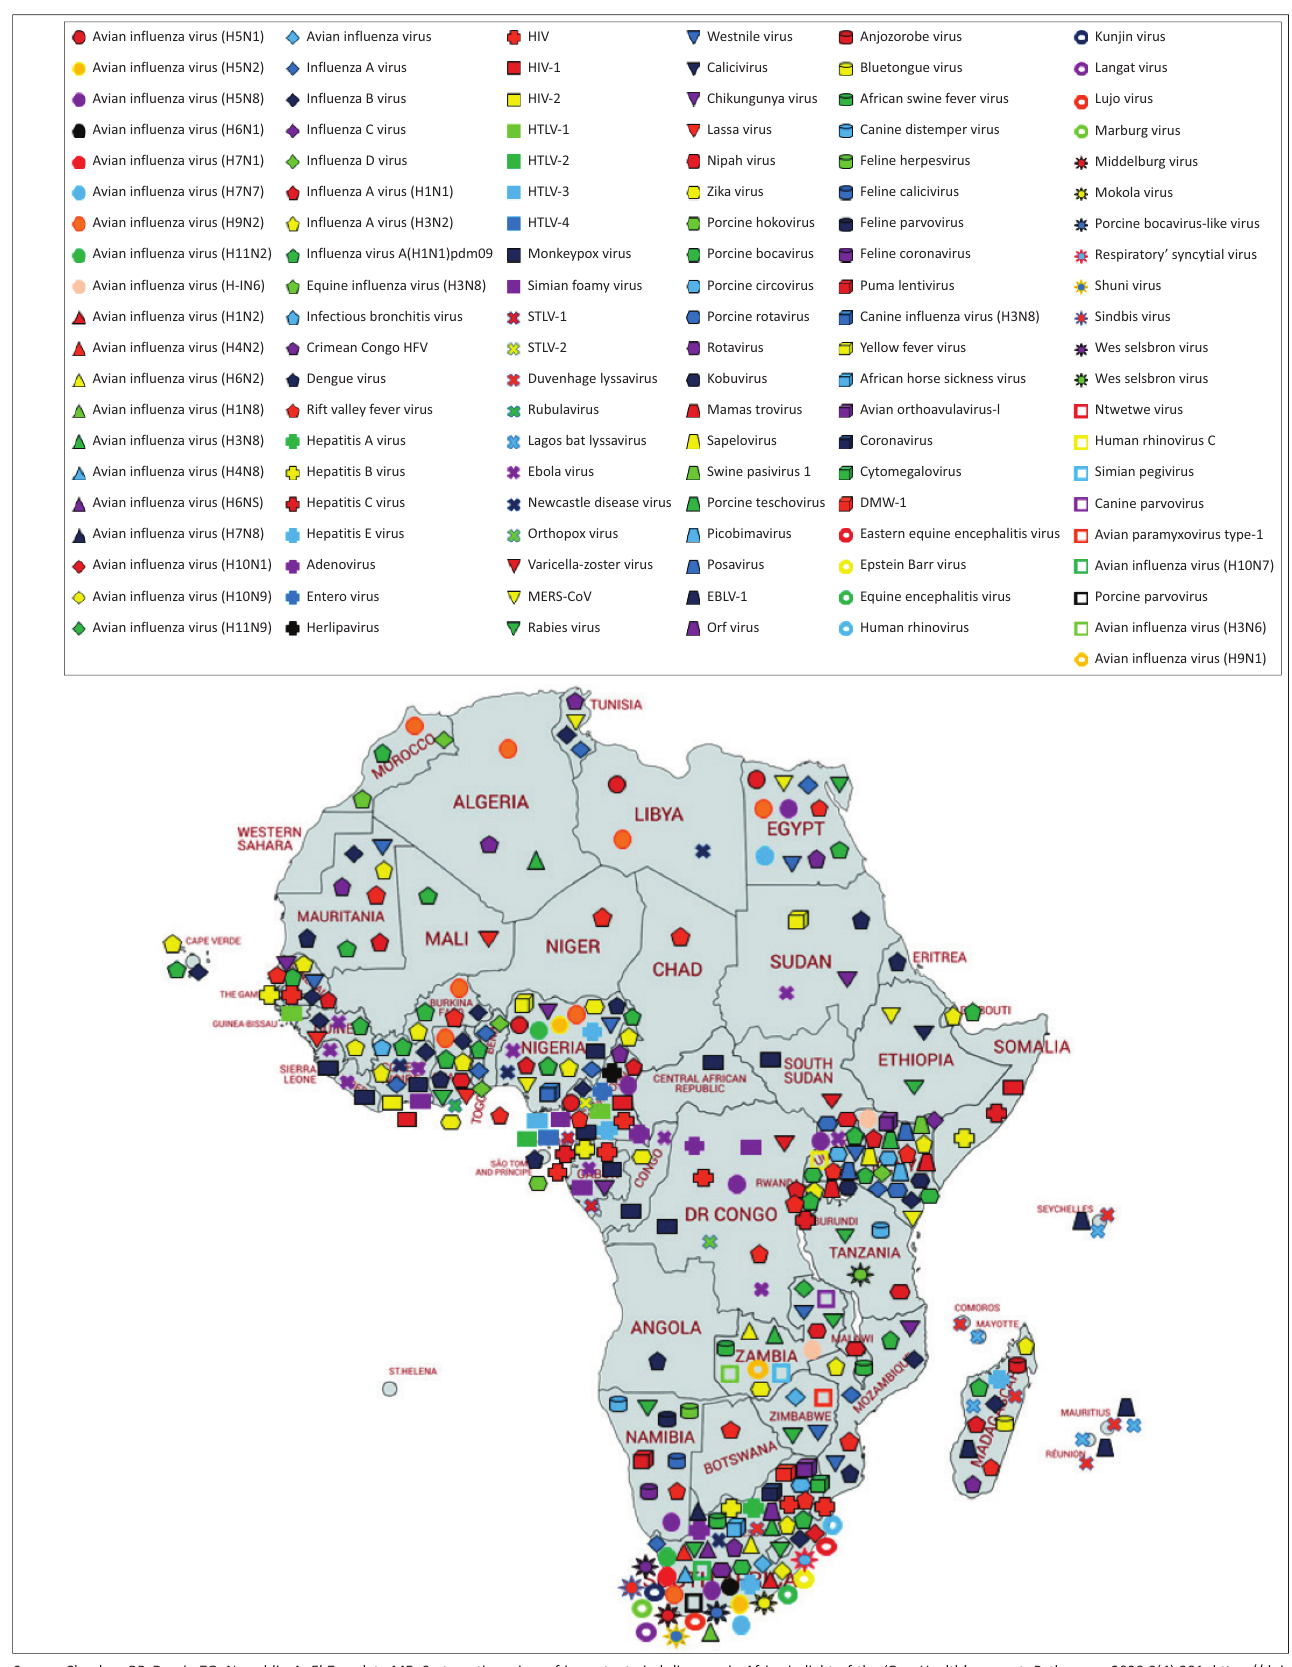
FIGURE 2: Map of Africa showing vector-borne and zoonotic virus diseases in Africa until September